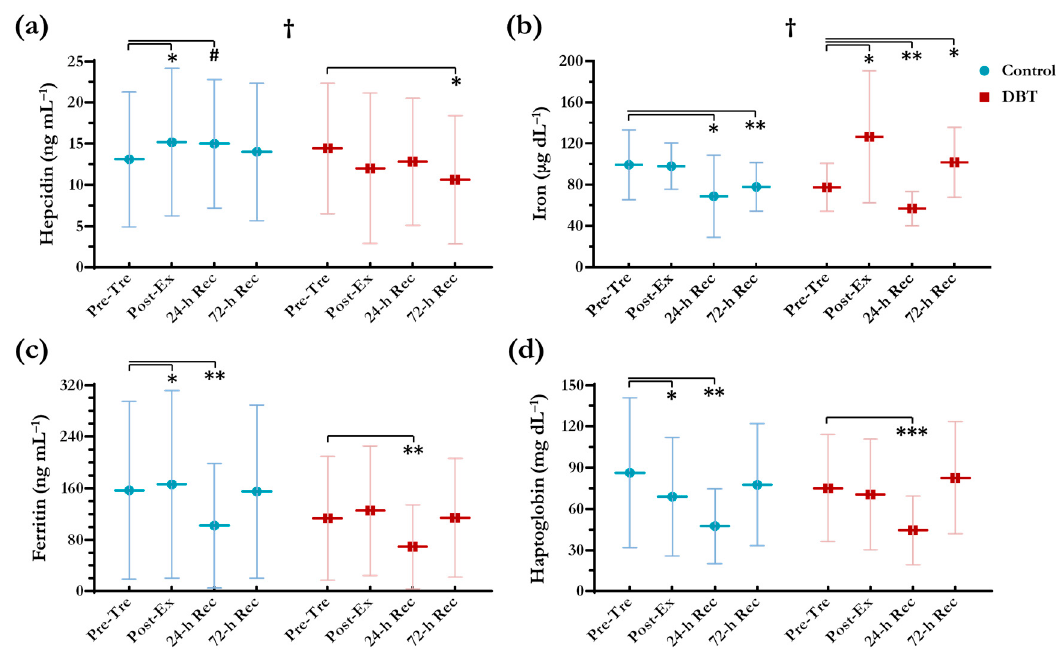
Figure 4. Changes in serum levels of ( a ) hepcidin, ( b ) iron, ( c ) ferritin, and ( d ) haptoglobin. † Significant group × time effect ( p < 0.05) analysed using two-way repeated measures ANOVA. # p = 0.050, * p < 0.050, ** p < 0.010, *** p < 0.001 as compared with Pre-Tre in each independent group using paired t ‐ test.